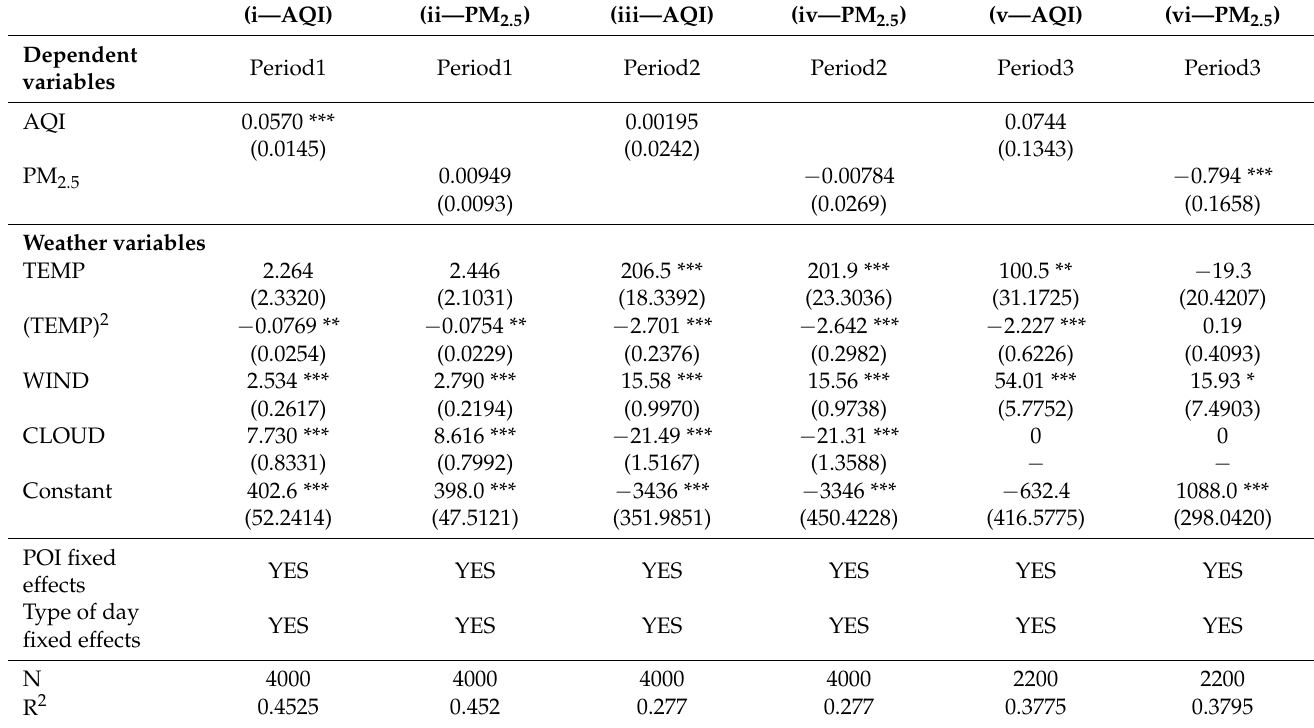
Table A12. Estimation of the effects of air pollution on people’s activity on the sightseeing POI.